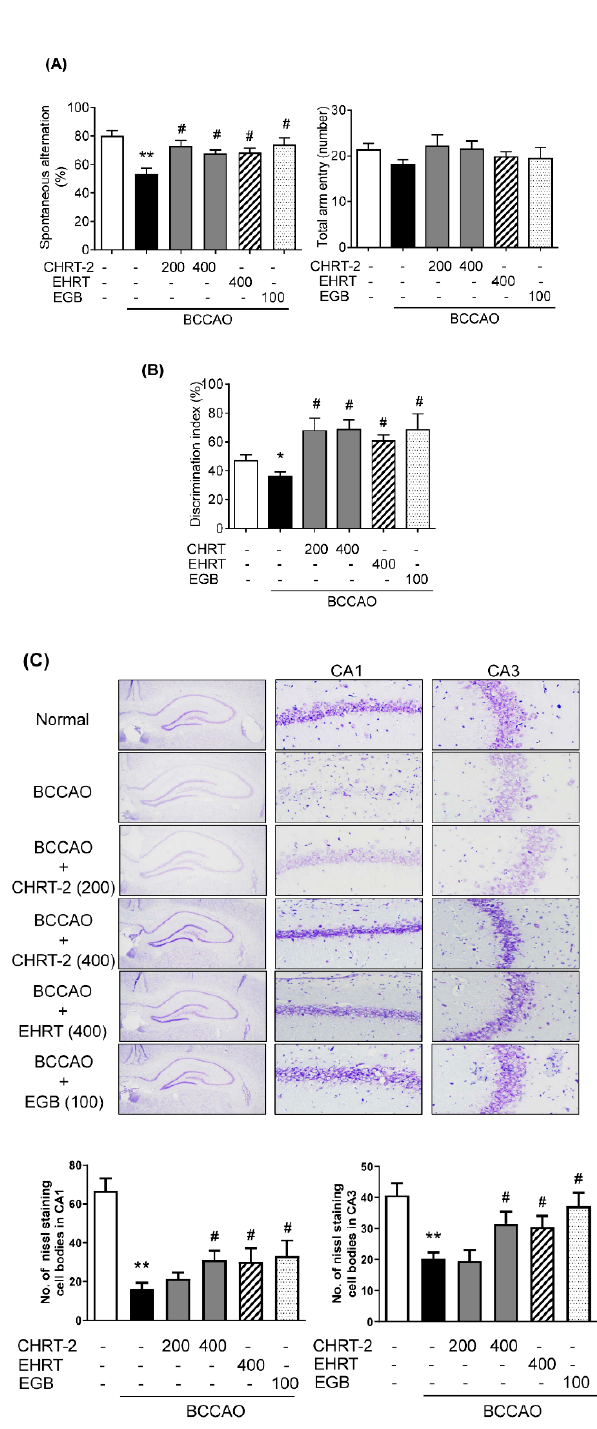
Figure 3. Effects of HRT on memory and cognitive impairment in BCCAO-induced vascular dementia (VaD) rats. ( A ) For the Y-maze test, the spontaneous alternation behavior (left) and the number of total arm entries (right) were monitored during a 10-min session. ( B ) For the novel object recognition test, the discrimination ratio was calculated as the ratio of time spent exploring the novel object or the object moved to a novel location to the total time spent exploring. Data are presented as means ± SEM; ** p < 0.01 vs. normal group, # p < 0.01 vs. BCCAO group. ( C ) Sections of the hippocampal Cornu Ammonis 1 and 3 (CA1 and CA3) regions were prepared and used for Nissl staining using cresyl violet solution. The graph shows the number (No.) of Nissl staining cells in CA1 and CA3. Representative photomicrographs are at magnifications of 400×. 2.3. Protective Effect of HRT against Neuronal Cell Loss in the BCCAO-Induced VaD Rat Model